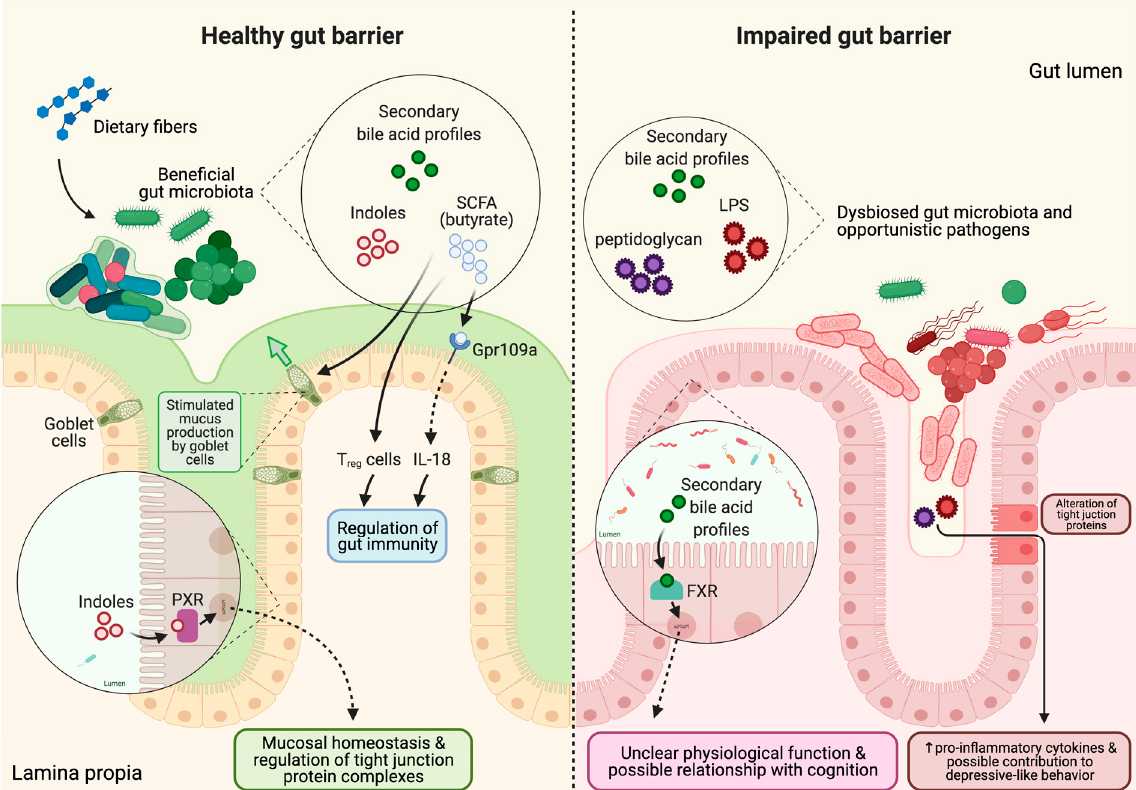
Figure 2. Gut barrier integrity changes and differences in signaling molecules in healthy vs. unhealthy gut. In healthy gut barrier, dietary fiber from diet is digested by the beneficial gut microbiota which produces secondary metabolites such as SCFA (butyrate), indoles, and secondary bile acid profiles. Butyrate is known to use Gpr109a as a receptor expressed in the enterocyte which produces IL-18, or it may directly affect T regulatory (T reg ) cells. IL-18 and T reg cells can both regulate the gut immunity. SCFA also stimulates mucus production by goblet cells for healthy mucosal barrier. Indoles are ligands for pregnane X receptor (PXR) acting as transcription factor in sustaining mucosal homeostasis and regulation of tight junction complexes. Secondary bile acid profiles are ligands for farnesoid X receptor (FXR) and can be found in both healthy and unhealthy gut. The physiological roles of secondary bile acid profiles are unclear and may have possible relationship with cognition. In impaired gut barrier, gut microbiota are dysbiosed and byproducts such as peptidoglycan and LPS are released from opportunistic pathogens. The mucosal barriers are attenuated which provides more close contact of pathogens near enterocytes altering tight junction proteins. The peptidoglycan and LPS may pass through compromised tight junction increasing pro-inflammatory cytokines and possibly contributing to depressive-like